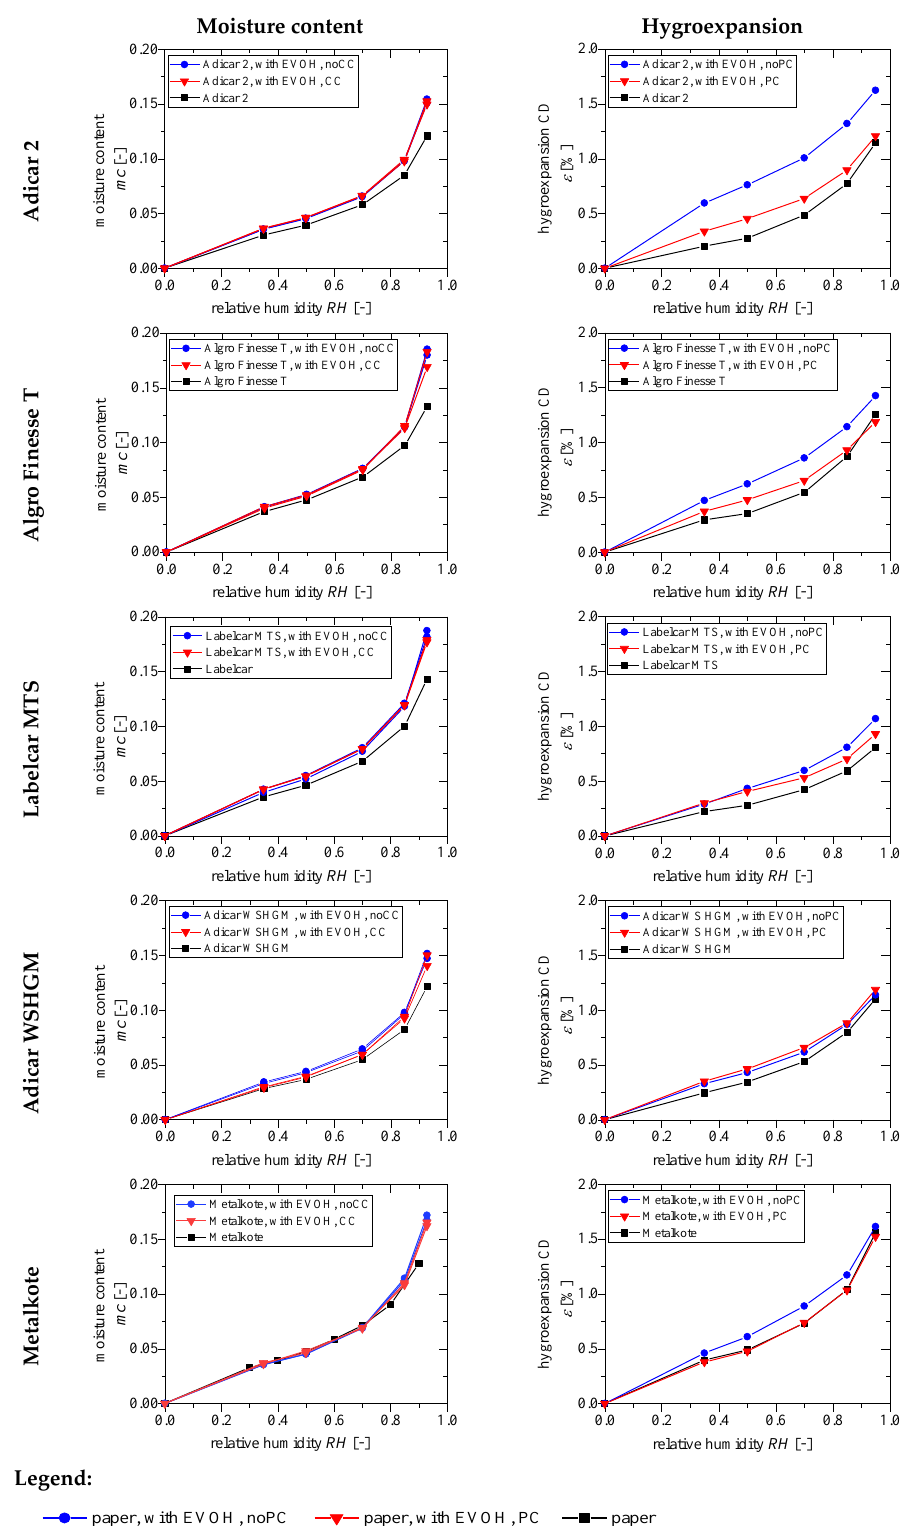
Figure 4. Moisture content ( mc ) and hygroexpansion ( ε ) increase with relative humidity ( RH ). The EVOH coating increased moisture content and hygroexpansion. Hygroexpansion increased more when the EVOH was applied to the noPC surface. PC/noPC = paper surface with/without pigment coating. EVOH = ethylene vinyl alcohol lacquer.